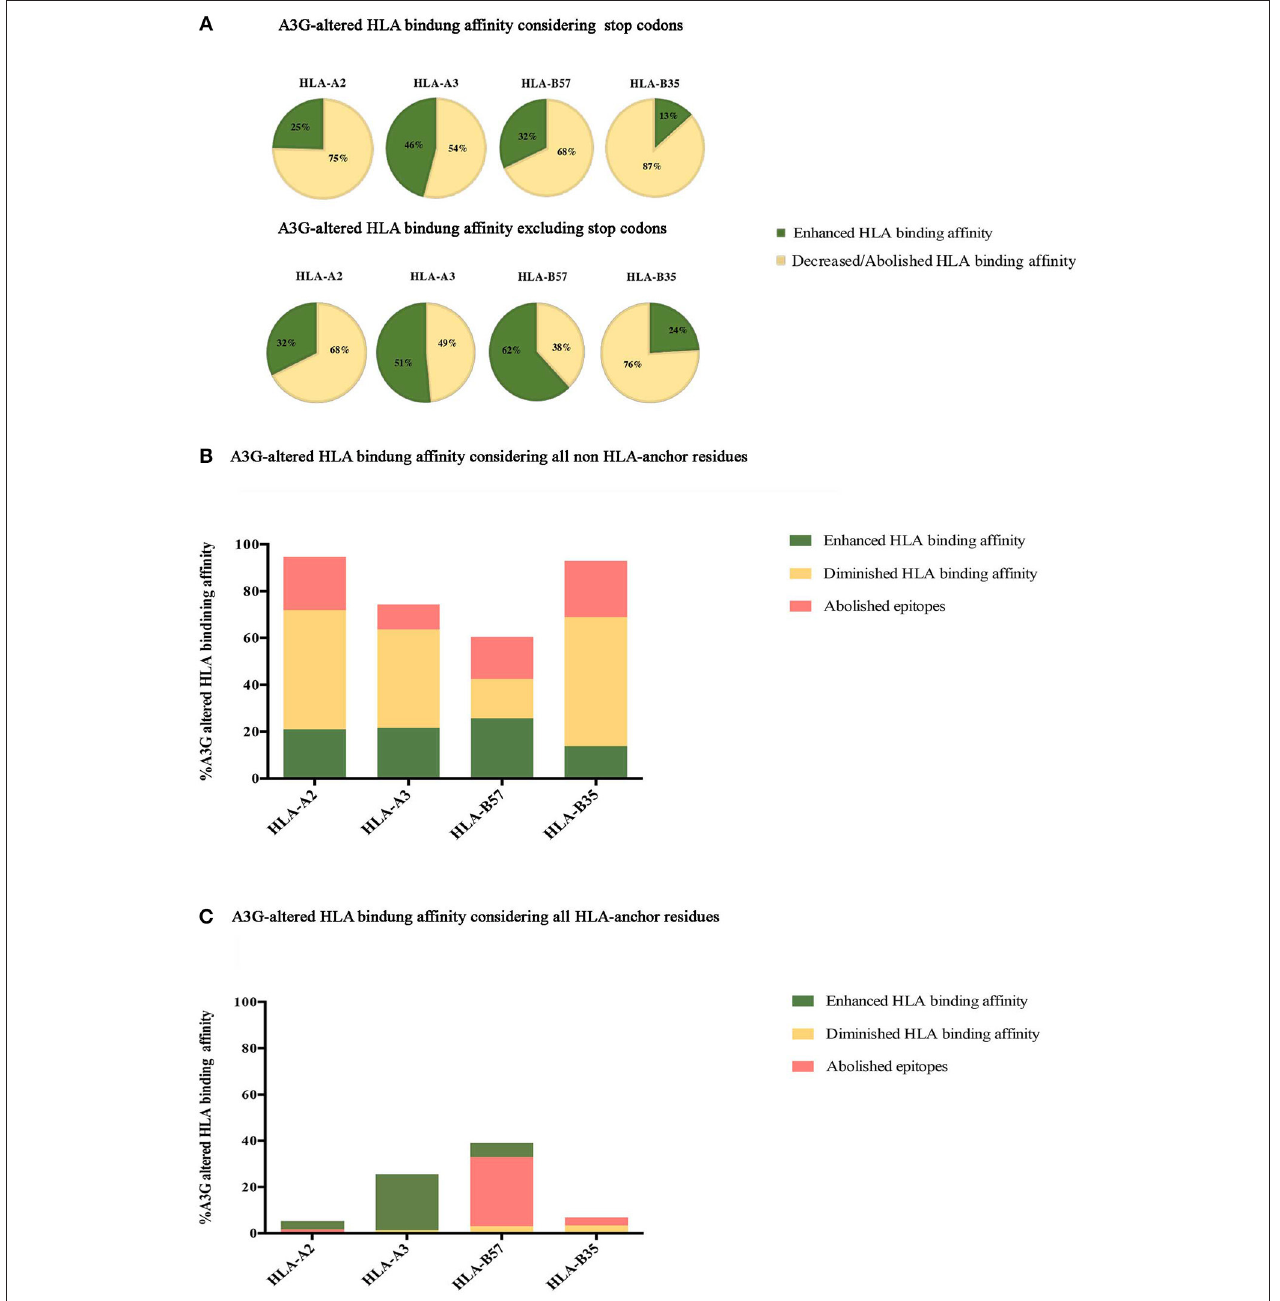
FIGURE 2 | Impact of A3G-induced mutations on HLA-binding. The impact of A3G-mediated mutations on HLA-binding affinity was predicted using NetMHCpan 4 to examine epitopes restricted to HLA-A2:01, HLA-A3:01, HLA-B57:01, and HLA-B35:01 for Gag, Pol, Env, and Nef proteins. Epitopes within the range of strong and weak HLA-binding affinity were considered as potential CTL epitopes. Delta value between A3G-mutated wild-type epitope scores were calculated with 0.1 rank difference as a threshold of meaningful difference for increased or reduced HLA binding affinity. (A) The impact of all A3G induced-mutations on HLA binding of epitopes in Gag, Pol, Env, and Nef restricted to HLA-A2:01, HLA-A3:01, HLA-B57:01, and HLA-B35:01 considering stop codon (top panel) and excluding stop codon (bottom panel). (B) The specific impact of A3G induced-mutations at non-anchor residues on HLA binding. (C) The specific impact of A3G-induced mutations on HLA-binding affinity considering only mutations at the N-terminal anchor position (amino acid residue 2 in a 8-11 mer) and the most C-terminal HLA anchor residue. resulted in decreased predicted proteasomal processing, whilst, 57, 44, 43, and 57% resulted in enhanced proteasomal